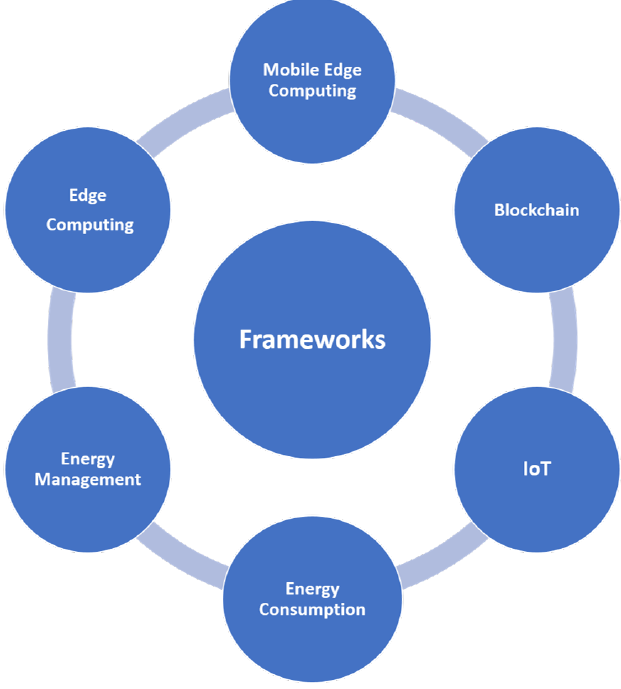
Figure 6. Common concepts in the analyzed